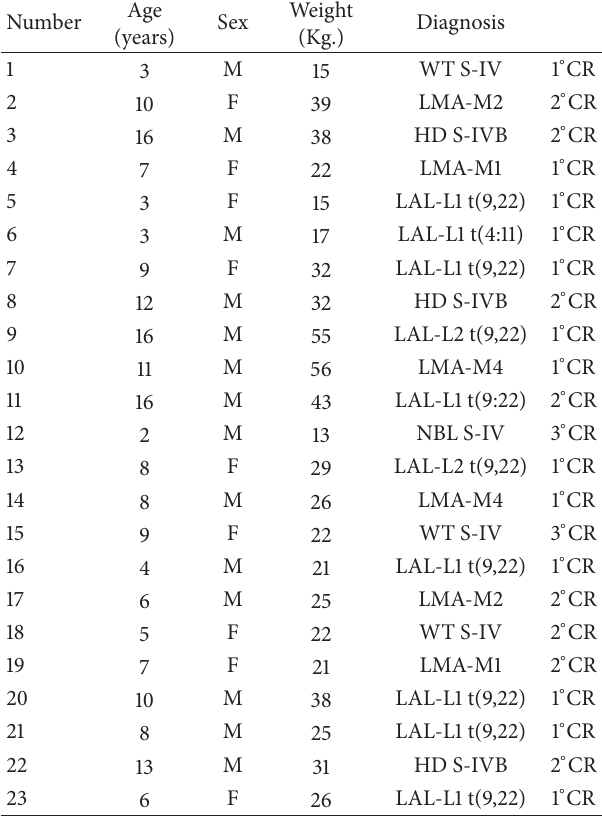
Table 1: Clinical characteristics of the